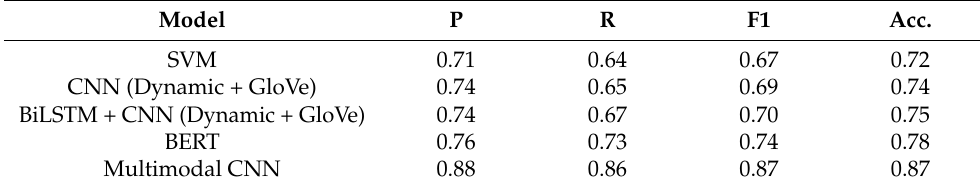
Table 11. Comparison of the best models